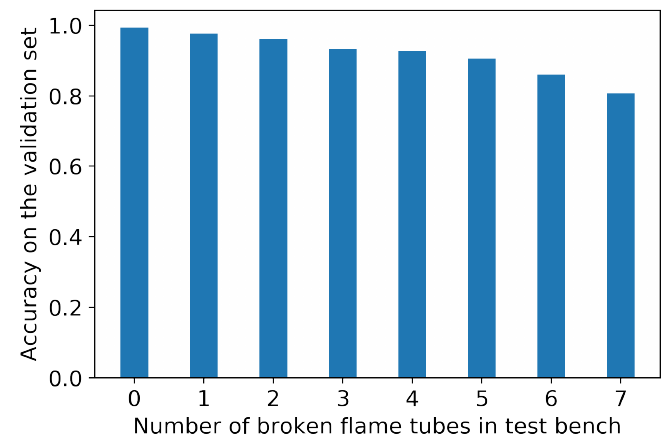
Figure 12. Absolute accuracy for different number of broken flame tubes.